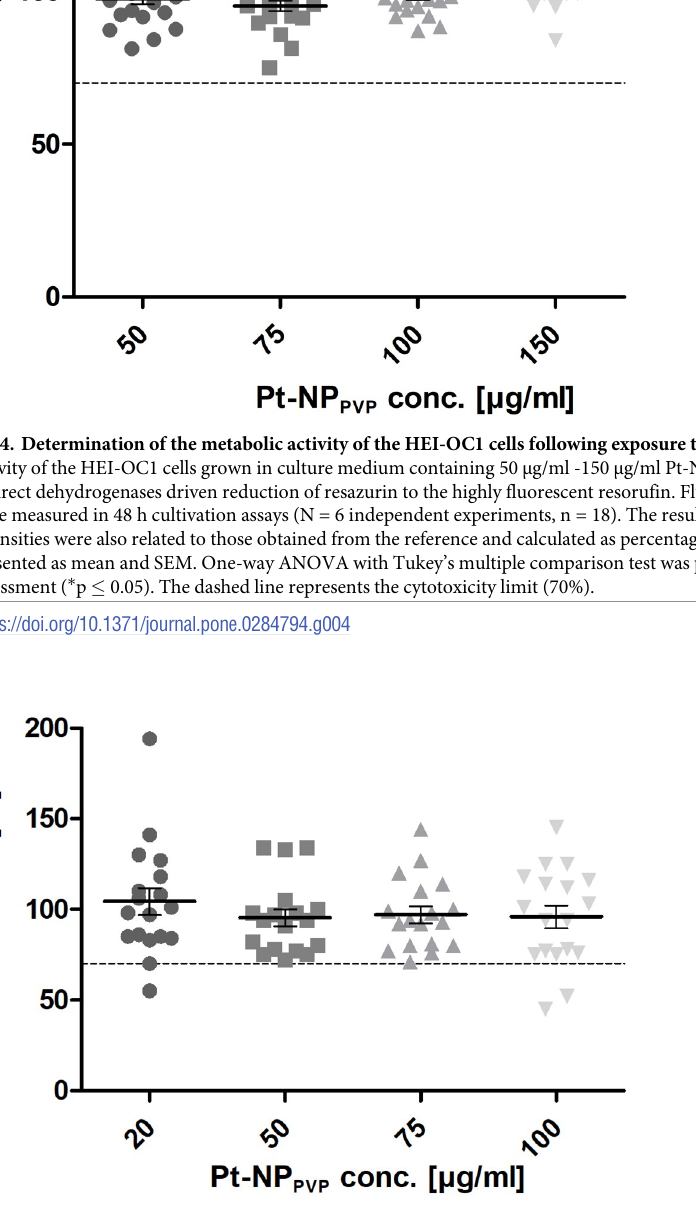
PLOS ONE | https://doi.org/10.1371/journal.pone.0284794 April 24,